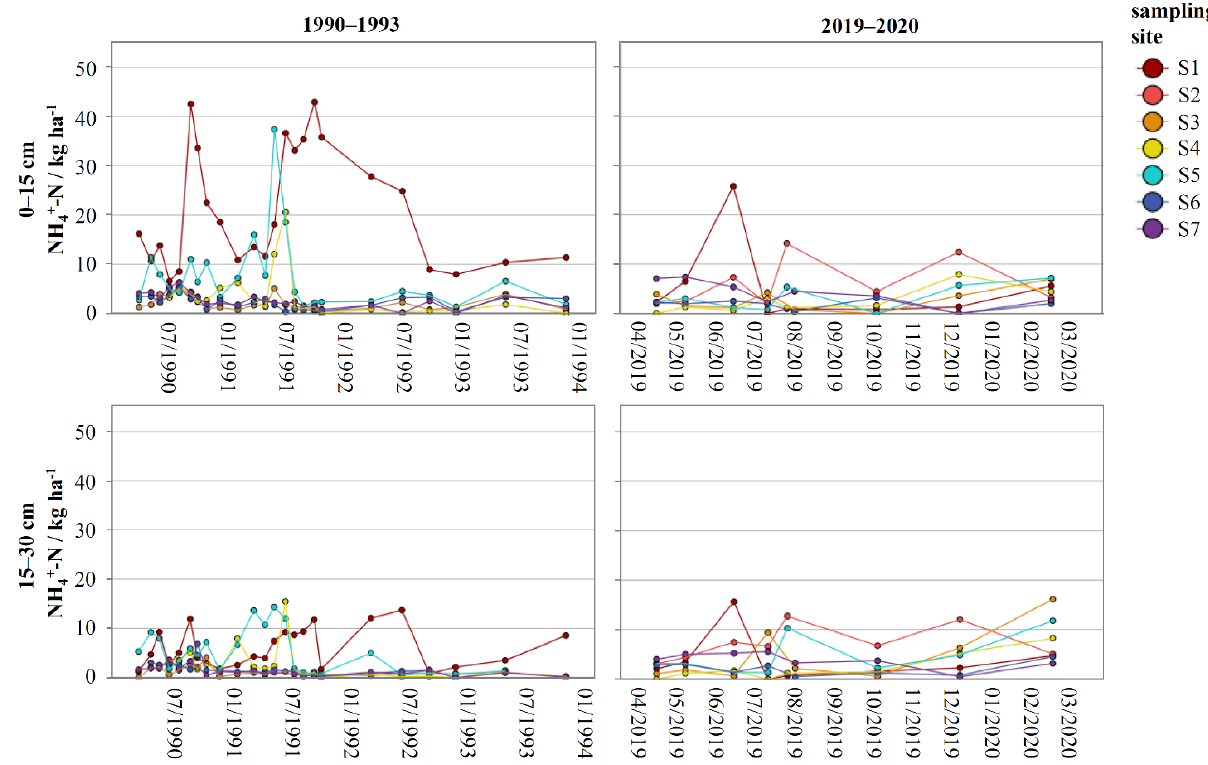
- -N content during the initial examination in 1990–1993 (Gebhardt & Figure 5. Scatter plots of soil NH 4 Knabke 1994) and during the follow-up examination in